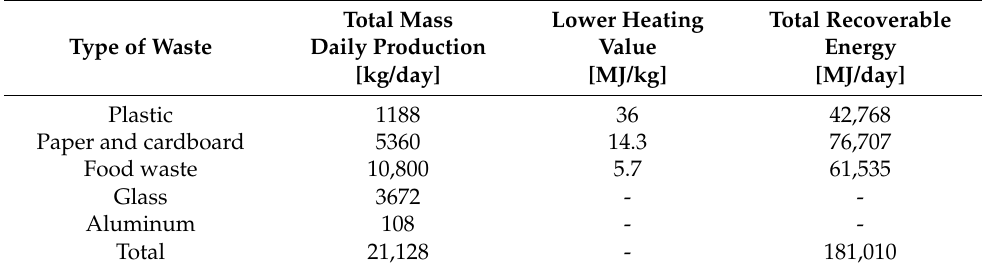
Table 1. Production of solid waste on board the reference vessel (5400 people on